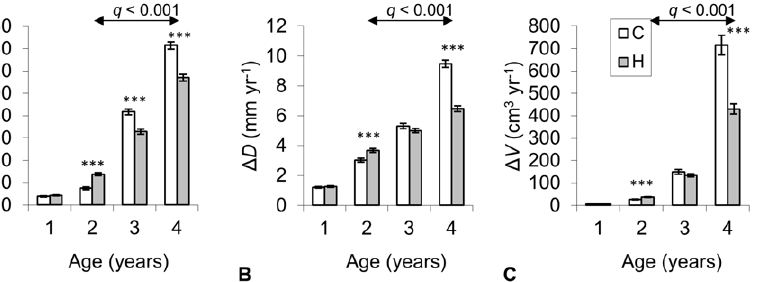
Figure 3. Height (a), diameter (b) and stem volume (c) increments ( D H , D D and D V respectively) of hybrid aspens in control (C) and humidified (H) plots during the study period. The significance of treatment effect ( t -test) in individual years is indicated with asterisks and q - values (model) show the summary effect over the years when humidification was applied (age 2–4 years). Whiskers denote 6 standard error. measured in the ratio 10 g: 25 ml using method ISO 10390.